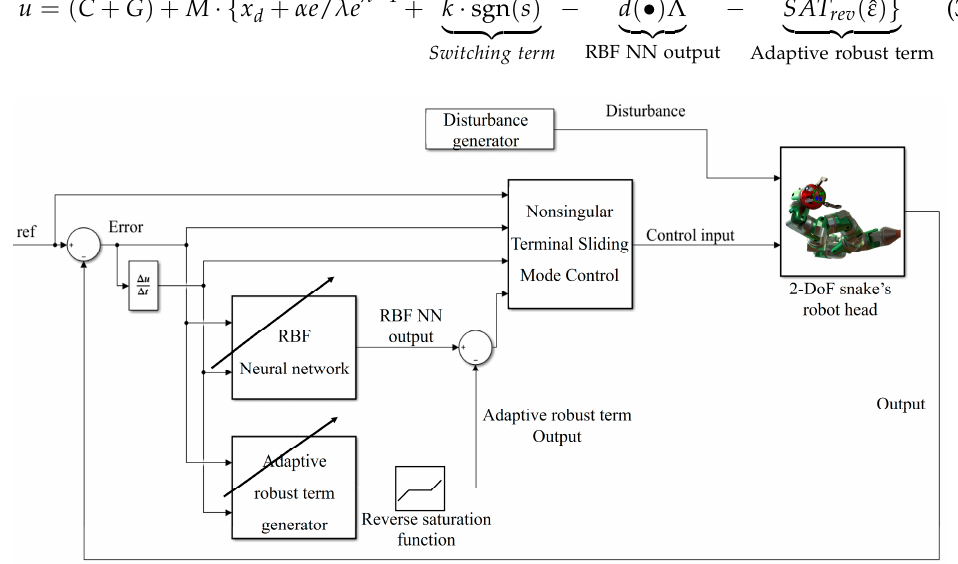
Figure 4. Proposed controller block diagram.